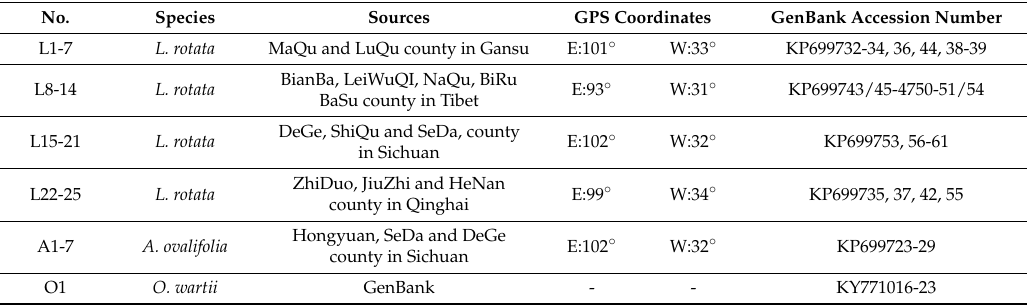
Table 3. The origins of the materials and GenBank accession numbers of ITS2